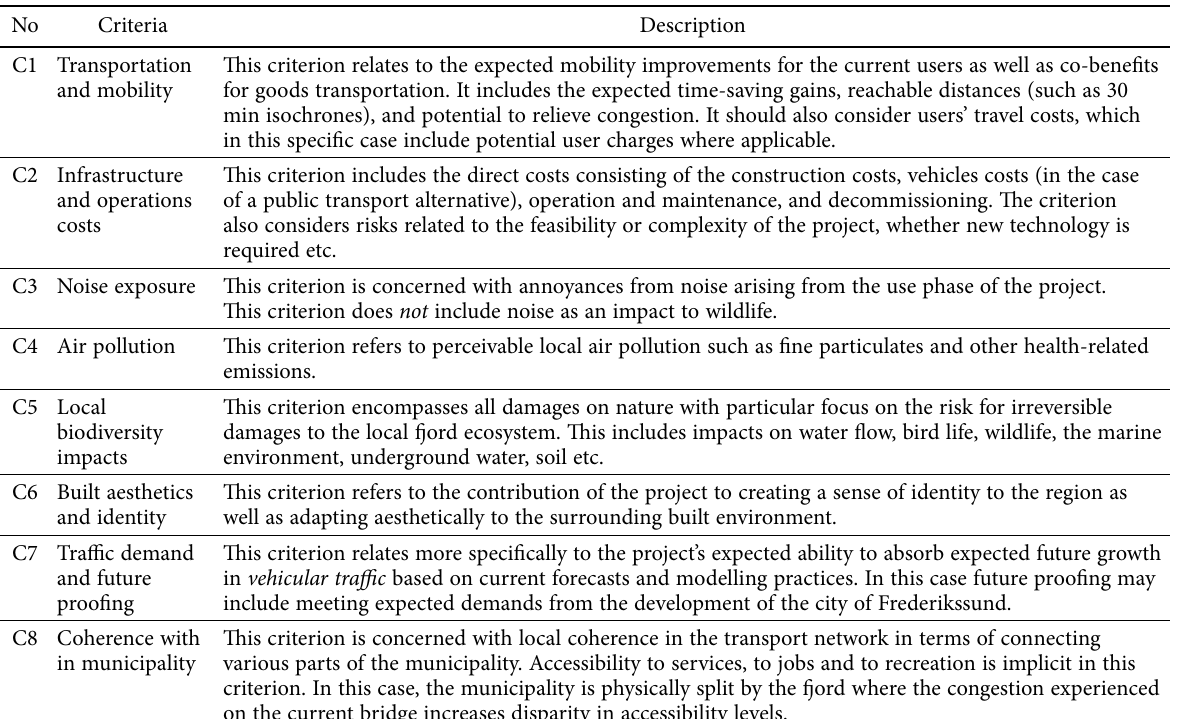
Table 2. Final set of assessment